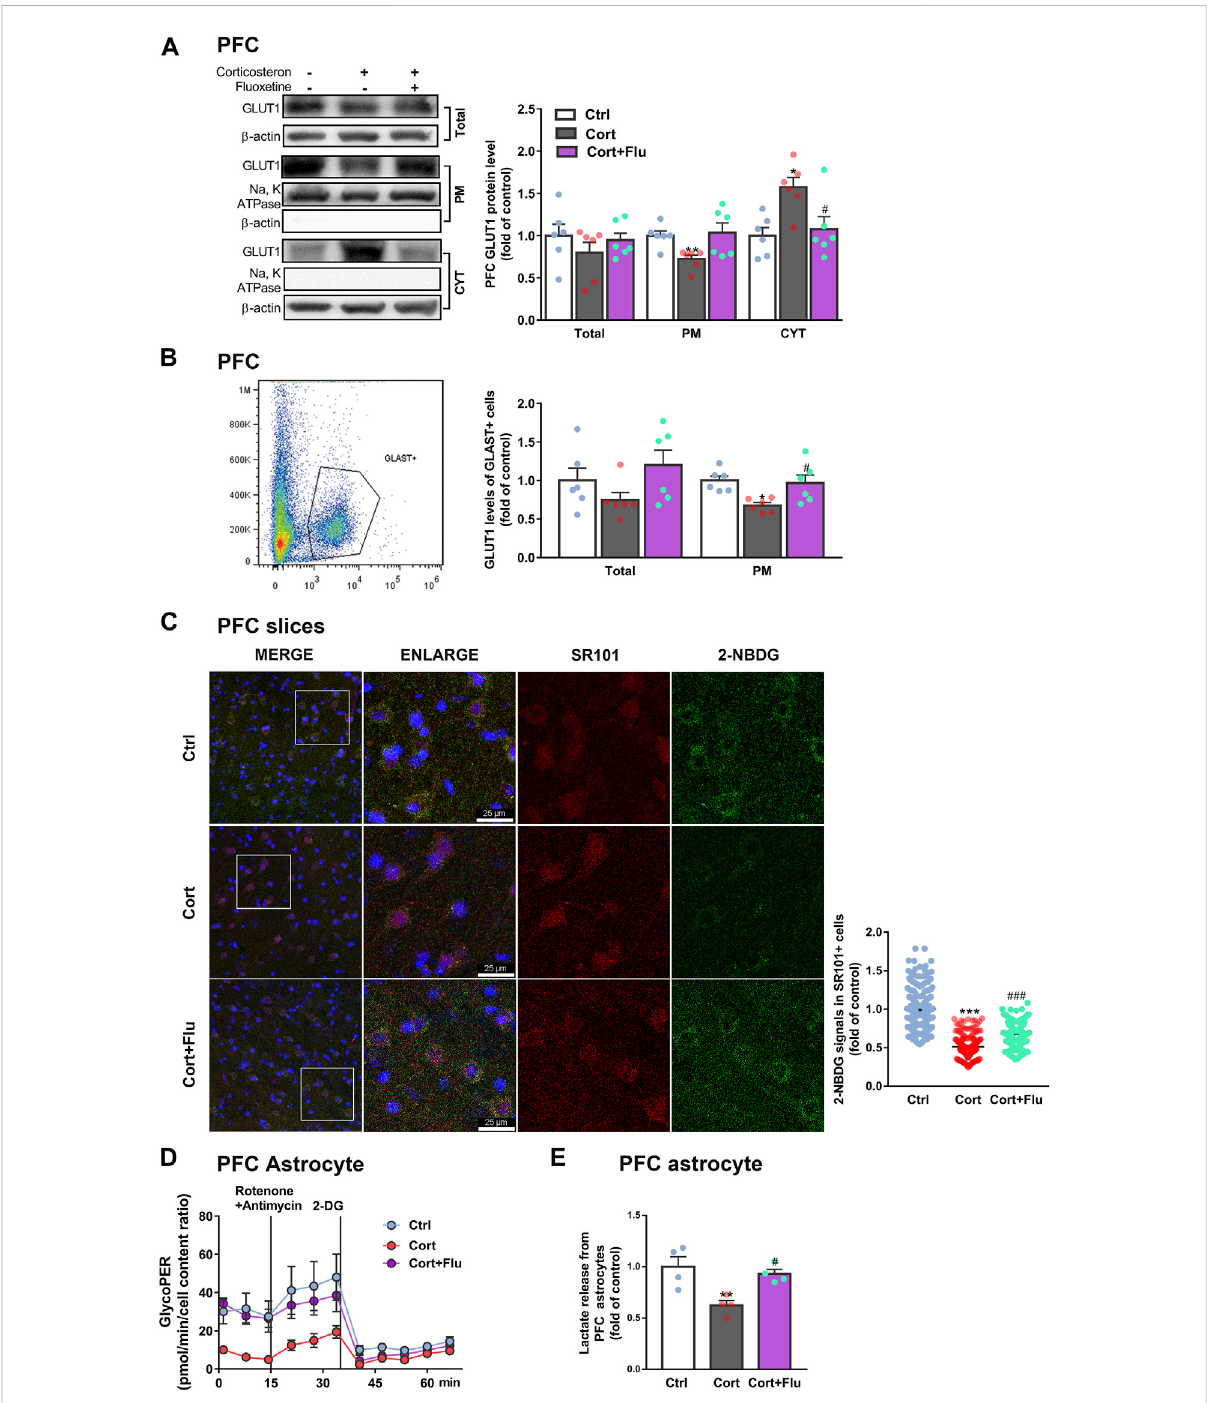
FIGURE 3 Fluoxetine recoversprefrontalcortexastrocyticglucoseuptakeandglycolysisinaratmodelofdepressioninducedbyrepeatedcorticosteroneinjection. (A) GLUT1 (total, PM and CYTfractions) proteinlevels in PFC of rats treated with fl uoxetine(10 mg/kg), n = 6 animals/group;Total: P CortxCort + Flu > 0.9999;PM: P CortxCort+Flu=0.0699;CYT: P CortxCort+Flu=0.0217. (B) TotalandPMGLUT1levelsinGLAST+astrocytesfromPFCofratstreatedwith fl uoxetine(10 mg/kg) weredetectedby fl owcytometry, n =6animals/group;Total: P CortxCort+Flu=0.1029;PM: P CortxCort+Flu=0.0231. (C) The fl uorescenceintensityof2- NBDGinSR101+cellsimagedbyconfocal(scalebar=25 μ m)andanalyzedbyImageJ,Ctrl: n =226cells,Cort: n =195cells,Cort+Flu: n =205cells; P CortxCort+ Flu < 0.0001. (D) GlycoPER(glycolyticprotonef fl ux)wascalculatedaccordingtotheresultsofseahorseglycolyticrateassay, n =4animals/group. (E) Lactatereleased fromPFCastrocytesof fl uoxetine(10 mg/kg)-treatedratswasdetected, n =4animals/group; P CortxCort+Flu=0.0203.Alldatawereexpressedasmean±SEM, * p < 0.05,** p < 0.01,*** p < 0.001vs.Ctrl(control)group, # p < 0.05, ### p < 0.001vs.Cort(corticosterone)group(NormalityofdatawascheckedbyShapiro-Wilktest. Data with or without normal distribution were analyzed by one-way ANOVA or Kruskal-Wallis test followed by Dunnett ’ s post-hoc test for multiple